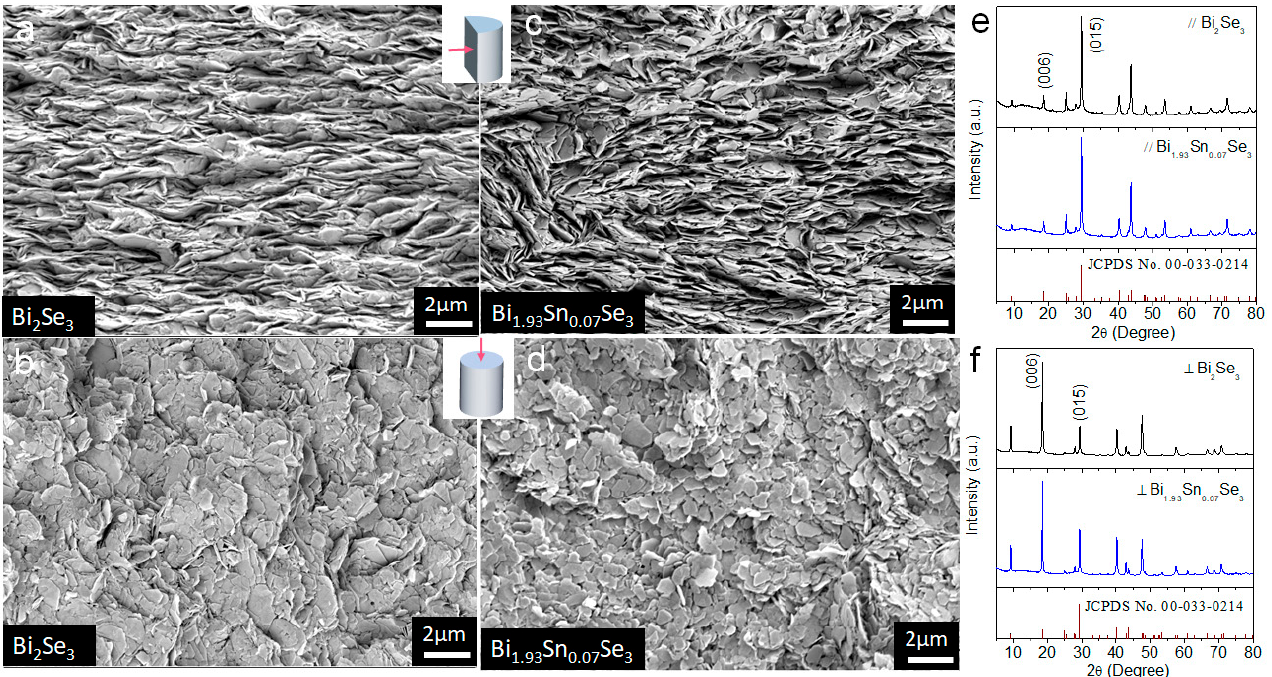
Figure 8. ( a , b ) Cross-section and top-view SEM micrograph of Bi 2 Se 3 . ( c , d ) Cross-section and top-view SEM micrograph of Bi 1.93 Sn 0.07 Se 3 . ( e , f ) XRD patterns of Bi 2 Se 3 and Bi 1.93 Sn 0.07 Se 3 measured in two perpendicular directions, along (//) and perpendicular ( ⊥ ) to the pressure axis.